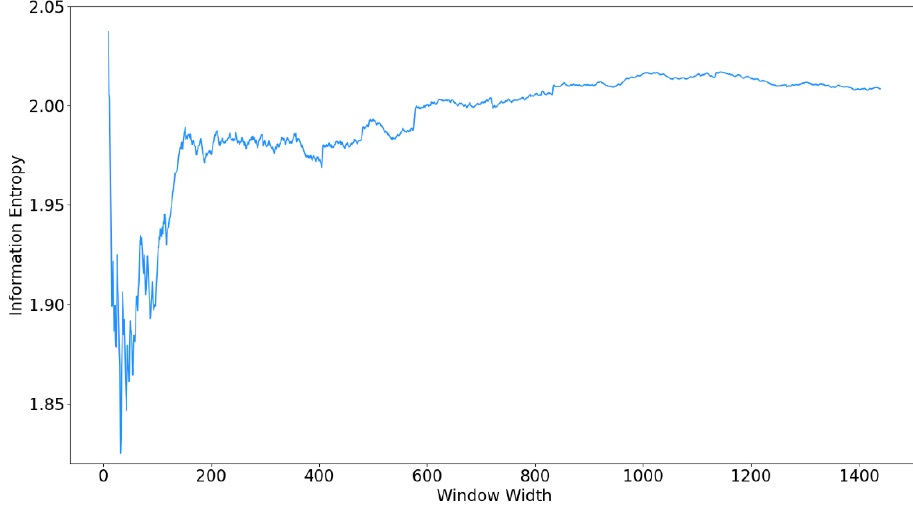
Figure 4. The information entropy calculated with different window widths.